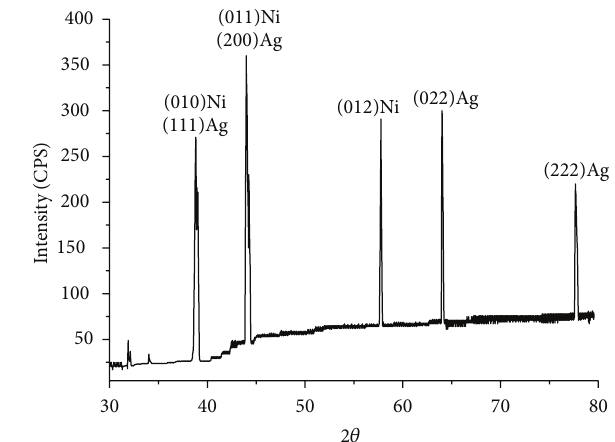
Figure 2: XRD pattern of nanocompound fluid.